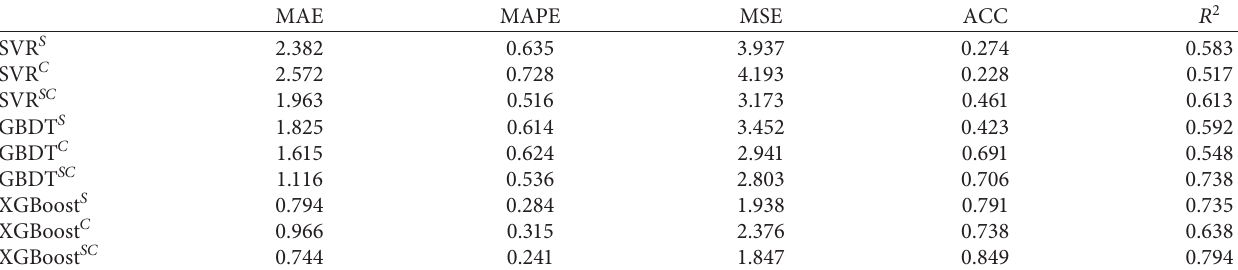
Table 5: Prediction results under 10% loss of data.